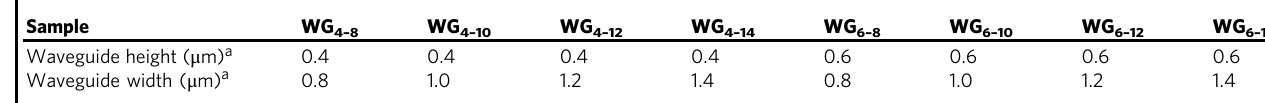
Table 1 Design parameters of the fabricated devices